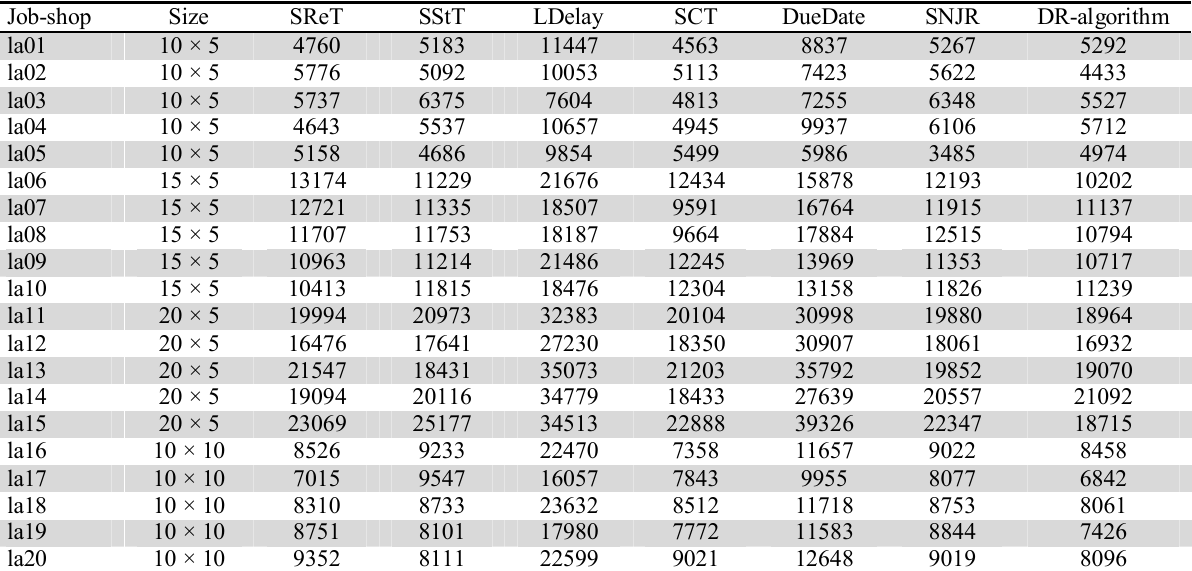
A comparison of DR-algorithm and six heuristic algorithms base on dispatching rules for the criterion